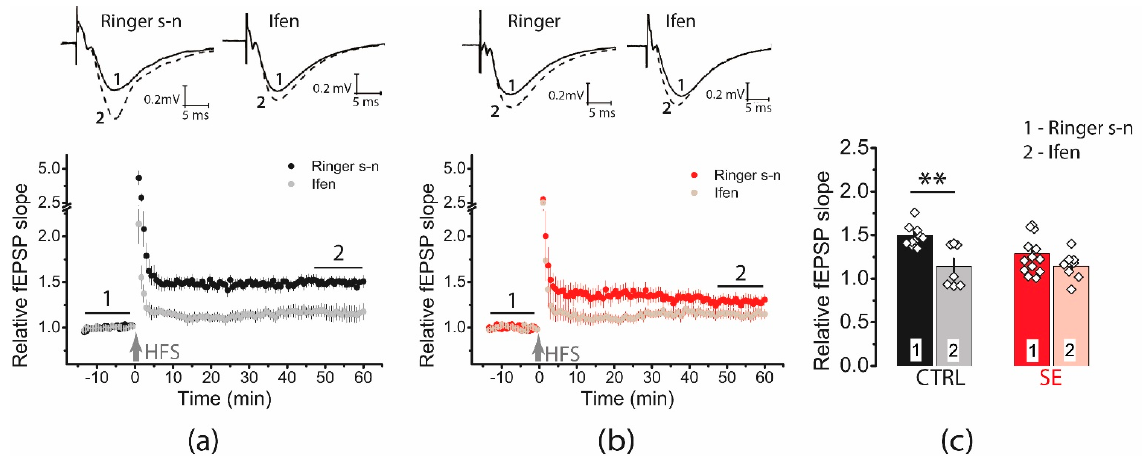
Figure 5. Diagrams showing the effect of ifenprodil (3 μ M), a GluN2B selective antagonist, on the normalized slope of fPSP in control (CTRL) ( a ) and post-SE ( b ) groups before and after HFS. ( c ) The bar graphs (mean ± SEM) showing the effect of ifenprodil on LTP values in different groups. Each rhombus represents a value obtained in an individual animal. Two-way ANOVA: F(seizure) 1,35 = 2.15, p = 0.15; F(ifenprodil) 1,35 = 12.10, p < 0.001; F(seizure × ifenprodil) 1,35 = 2.37, p = 0.13 following with Tukey’s post hoc tests: ** p <